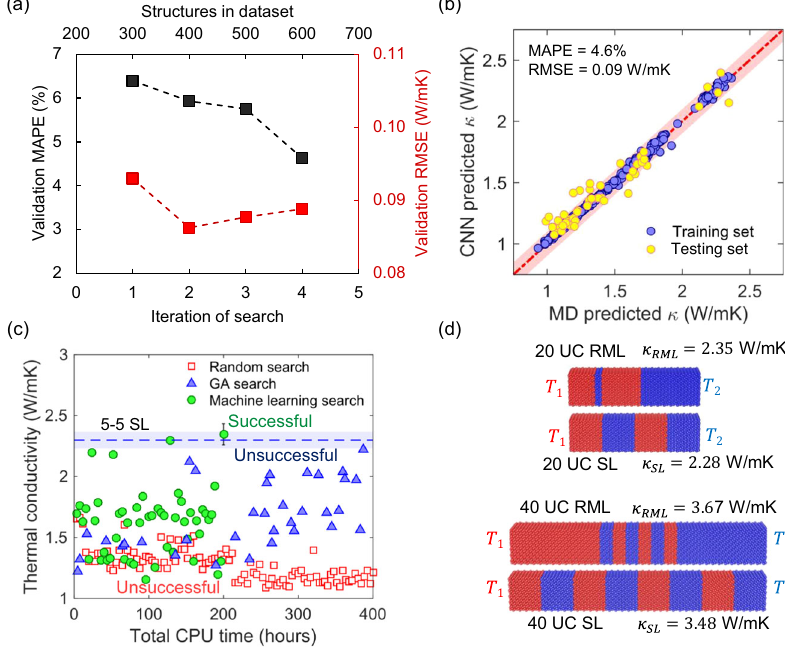
Fig. 3 Results of the machine learning based search for periodic superlattices with enhanced thermal conductivity. a Variation of testing MAPE (black squares, left axis) and RMSE (red squares, right axis) with each iteration of the iterative search process for the 20 UC RML system. The top axis indicates the size of the dataset on which the CNN is trained in that iteration of the search. b Comparison of CNN predicted κ l and NEMD calculated κ l (true value) for the dataset of RML structures. The shaded area represents a ±0.1 W/mK bound from y = x . c Thermal conductivities of 20 UC RMLs sampled by the random search (squares), a Genetic Algorithm search (triangles), and the CNN accelerated search (circles) with total computational time spent in CPU hours. The dashed line represents the κ l of the 5-5 SL structure, with error bounds from MD simulations as de fi ned in the main text. Error bars are also shown for the identi fi ed exceptional structure. d The 20 UC and 40 UC RML structures with higher thermal conductivities than the corresponding SLs which were identi fi ed by the CNN accelerated